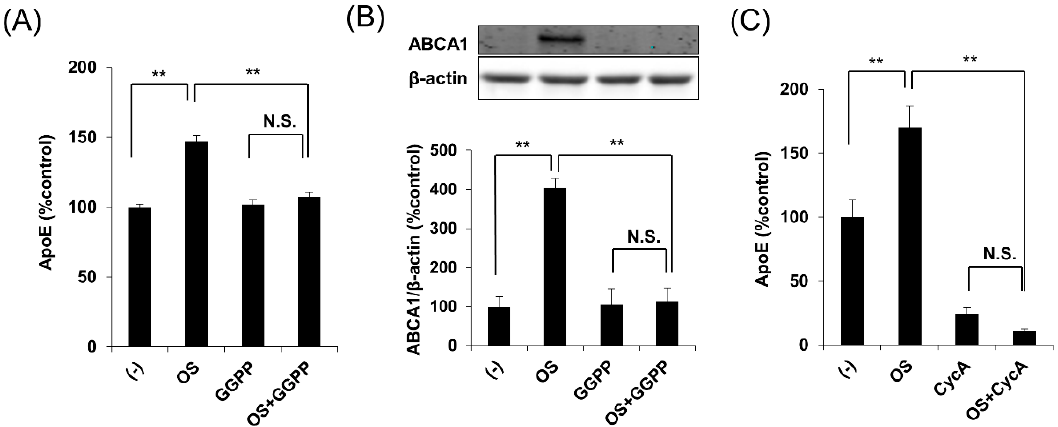
Figure 4. LXR-ABCA1 antagonists block the OS-induced increase in apoE secretion. ( A ) apoE levels in culture media and ( B ) cellular ABCA1 levels in immortalized astrocytes derived from apoE3-TR mice were determined by ELISA ( A ) or Western blotting ( B ) after treatment for 24 h with OS (1 µ M) in the absence or presence of an LXR antagonist, GGPP (10 µ M). ( C ) apoE levels in culture media of immortalized astrocytes derived from apoE3-TR mice were determined by ELISA after treatment for 24 h with OS (1 µ M) in the absence or presence of an ABCA1 antagonist, cyclosporin A (CycA, 10 µ M). Data represent mean ± SE ( A , C : n = 4, biological replicate group, B : n = 3, biological replicate group). ** p < 0.01, NS; non-significant; Tukey-Kramer test .